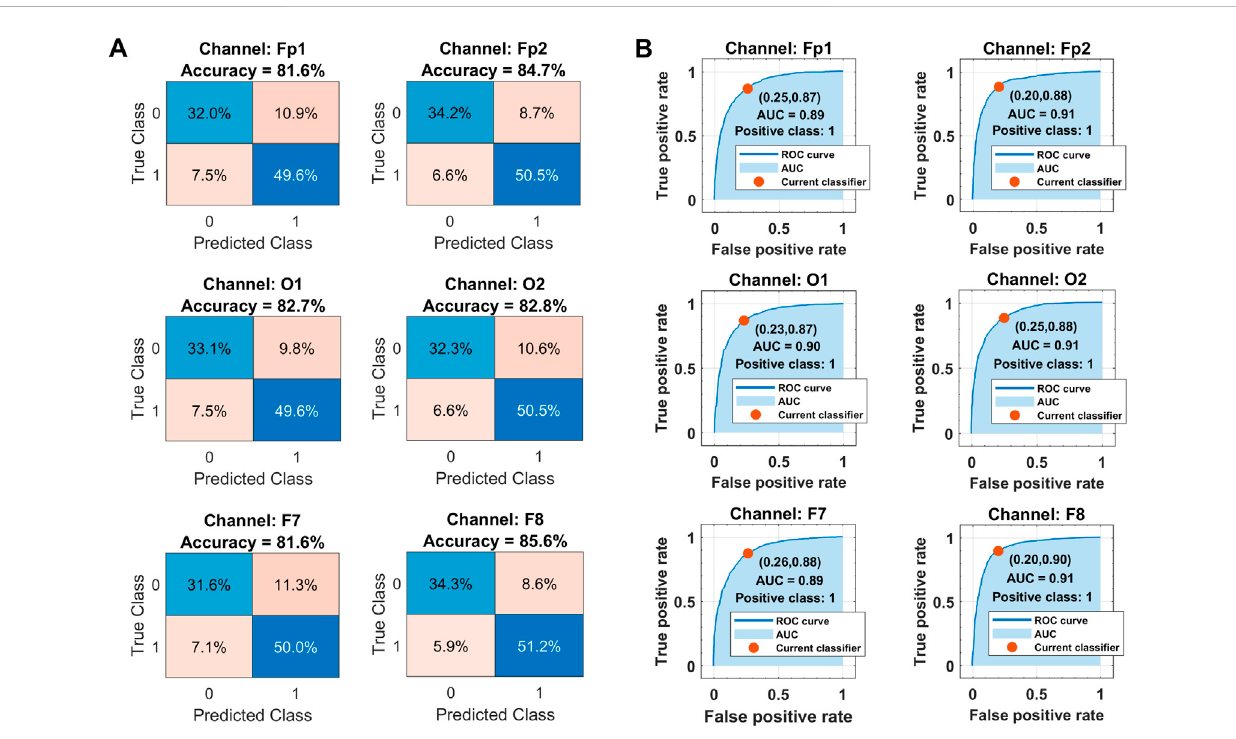
FIGURE 11 (A) Classi fi cationresults intermsofconfusion matrices. (B) Receiver operatingcharacteristics curvesoverall subjects ’ dataineachselectedchannel with Bayesian optimization-based ensemble classi fi er. Class labels: 1 = drowsy, 0 = alert.